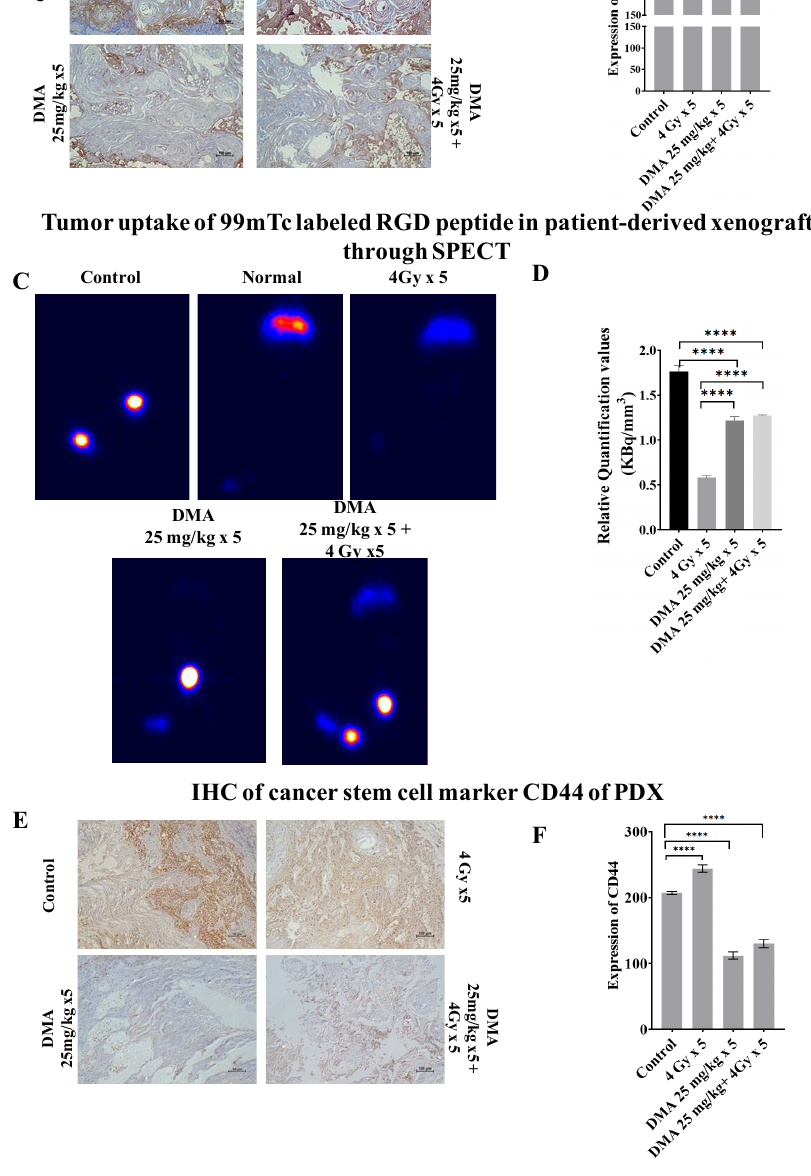
Figure 6. Abrogation of integrin and CD44 expression results in reduced tumor metastases. ( A ) Representative images depicting immunostaining for integrin β3. ( B ) Bar graph showing immunostaining quantification of integrin β3. ( C ) Comparison of tumor uptake of 99mTc-labeled RGD peptide in the patient-derived xenograft using SPECT for control (no treatment given to mice with tumor), normal (no treatment given to mice without tumor), radiation alone (4 Gy × 5), DMA (25 mg/kg × 5), and DMA treatment for 2h followed by radiation (DMA 25 mg/kg + 4Gy × 5). ( D )